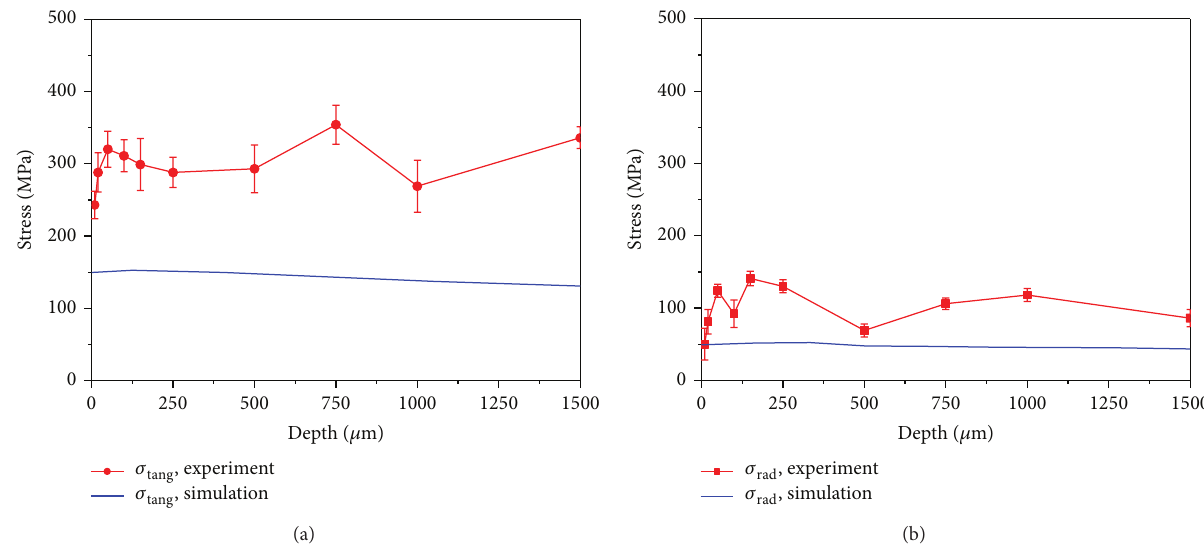
Figure6:Comparisonofsimulatedandmeasured(byX-raydiffraction)residualstressdepthprofilesonacylinderwithadiameterof100mm, quenched by 6 bar nitrogen pressure. (a) Tangential stress component on the lateral surface (spot P1). (b) Radial stress component on the top surface (spot